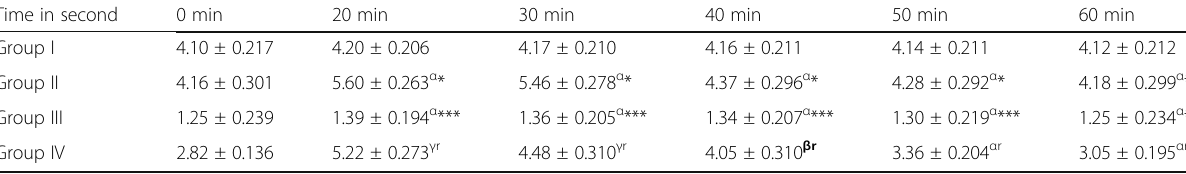
The values represent as Mean ±SEM for 6 rats each. The results are expressed in ng/mL. α = ( P > 0.05), β =( P <0.05), γ = ( P <0.01) represents comparison of 0 min reading of each group with 20,30,40,50 and 60 min. *= ( P >0.05), ** =( P < 0.05), ***= ( P <0.01) represents comparison of Group-II, III with Group-